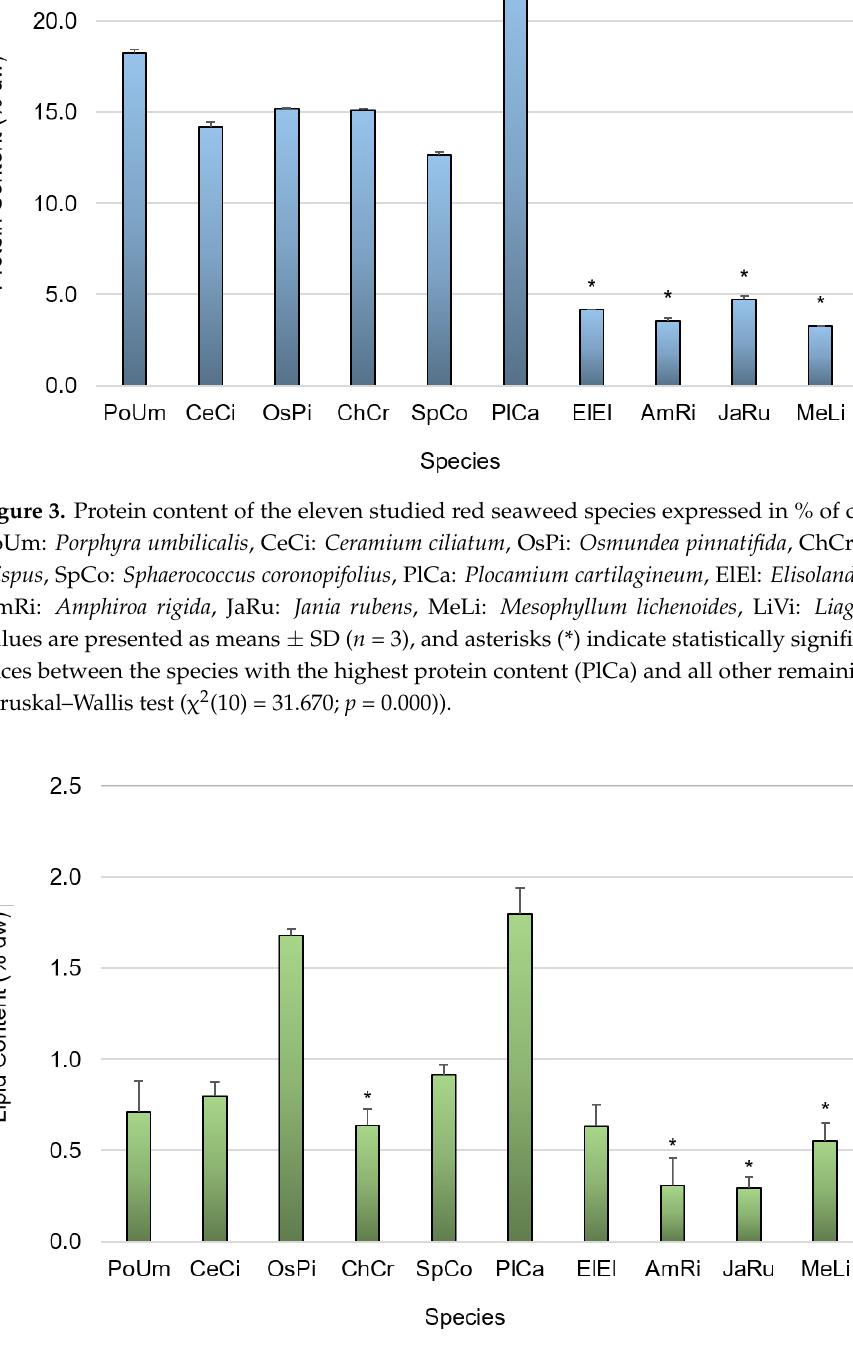
Figure 3. Protein content of the eleven studied red seaweed species expressed in % of dry weight. PoUm: Porphyra umbilicalis , CeCi: Ceramium ciliatum , OsPi: Osmundea pinnatifida , ChCr: Chondrus